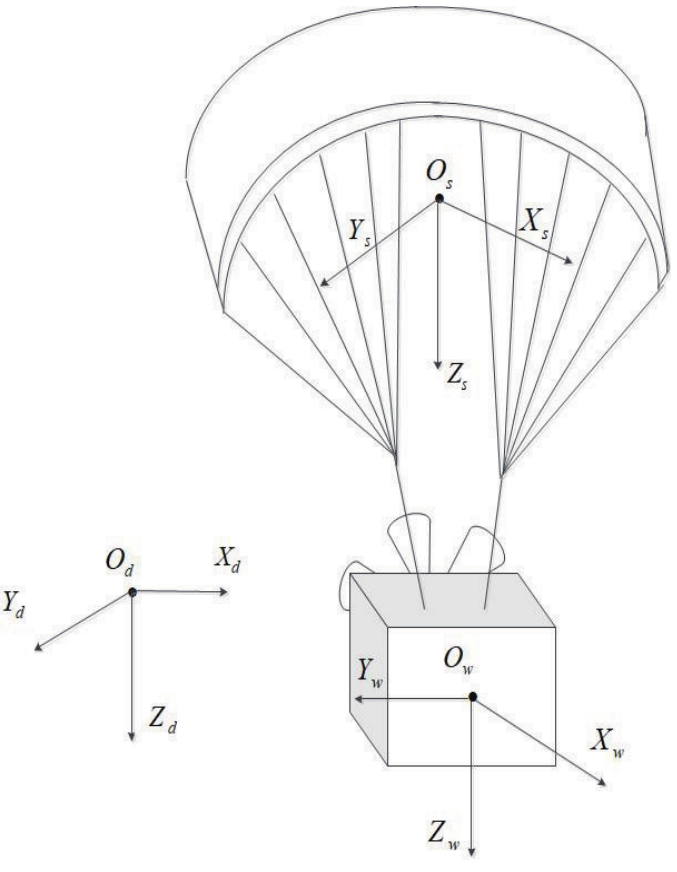
Figure 1. The structure of the powered parafoil and coordinate